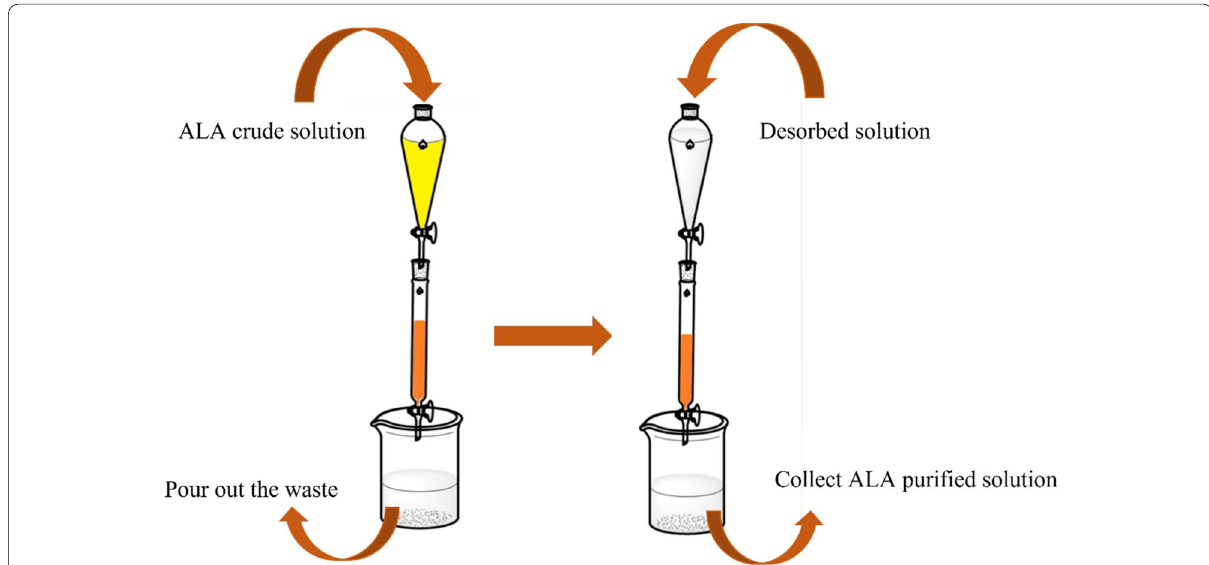
Fig. 3 ALA ion exchange process. The resin is filled in the chromatography to adsorb 5‑ALA and then washed out by eluent